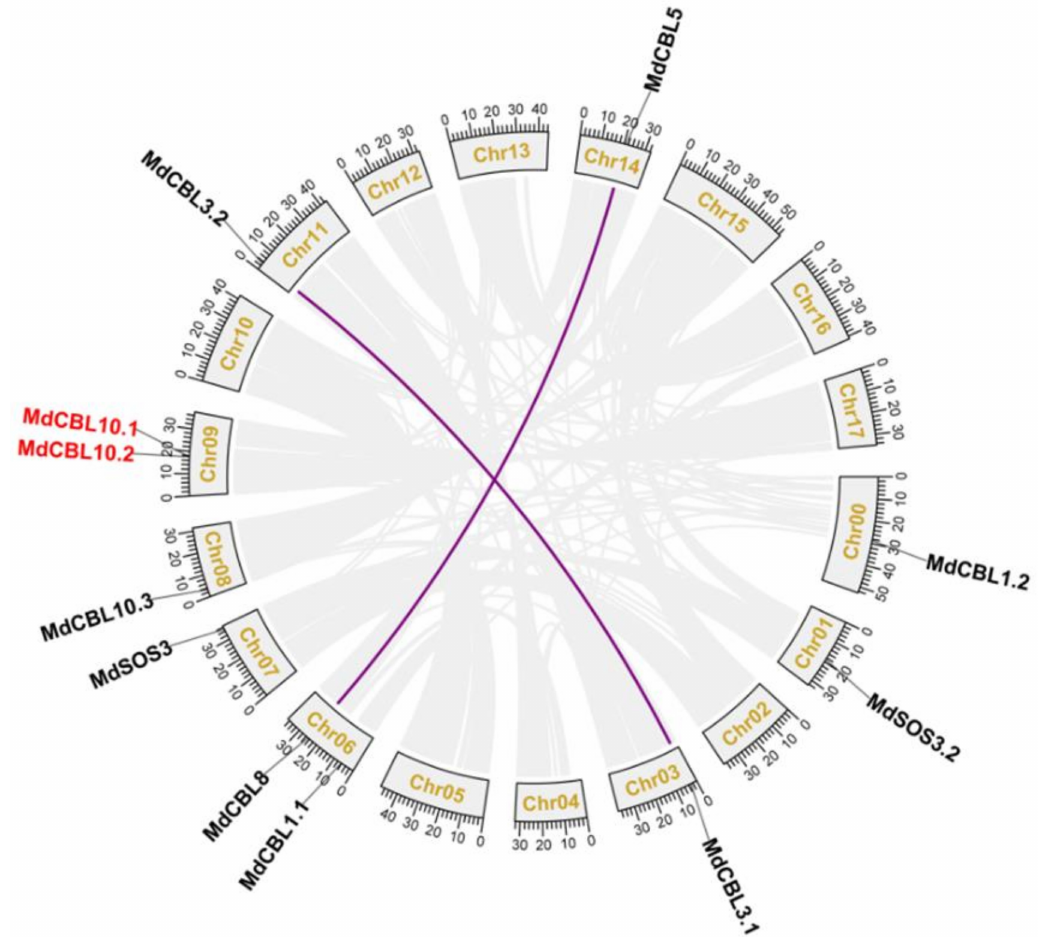
Figure 1. Genome locations of CBL family genes in apple. Purple lines and red font indicate the segmental and tandem duplication genes, respectively. Collinear blocks are represented by grayish lines. Chr00 represents the unassembled genomic scaffolds.